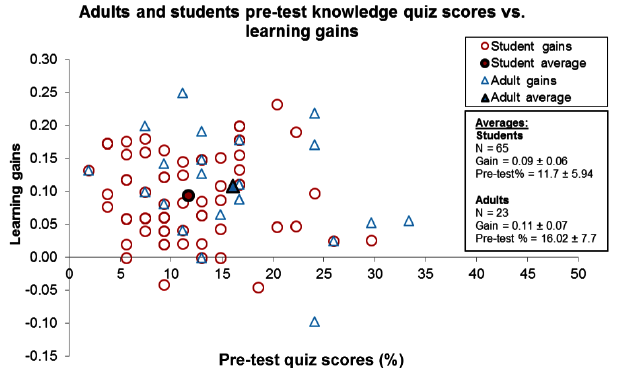
Figure 4. Graph showing the preliminary learning gains for both adult and student participants and the averages for both populations. Overall, both sets of participants show positive learning gains with the average adult learning gains (0.11) similar to those of the student participants